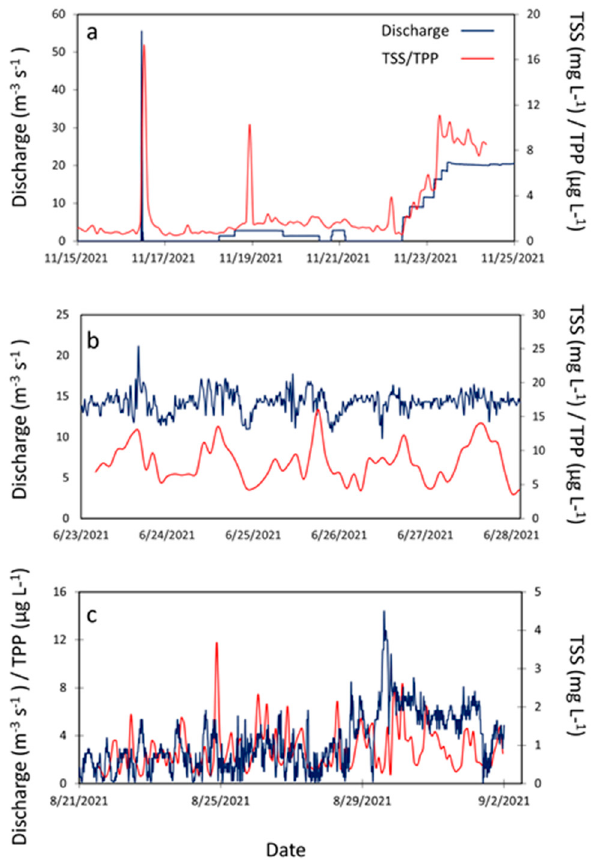
Figure 5. Time series of discharge and estimates of TSS and TPP from the ADV deployments at ( a ) upstream (UP), ( b ) downstream (DS), and ( c ) interior (INT) sites. The TSS and TPP estimates are those near the canal bed. During the field deployments at UP and INT, the measured backscatter obtained from the ADV was lower than the measured backscatter obtained during the lab calibrations because of the inability to artificially create very low TSS concentrations in the lab (<5 mg L − 1